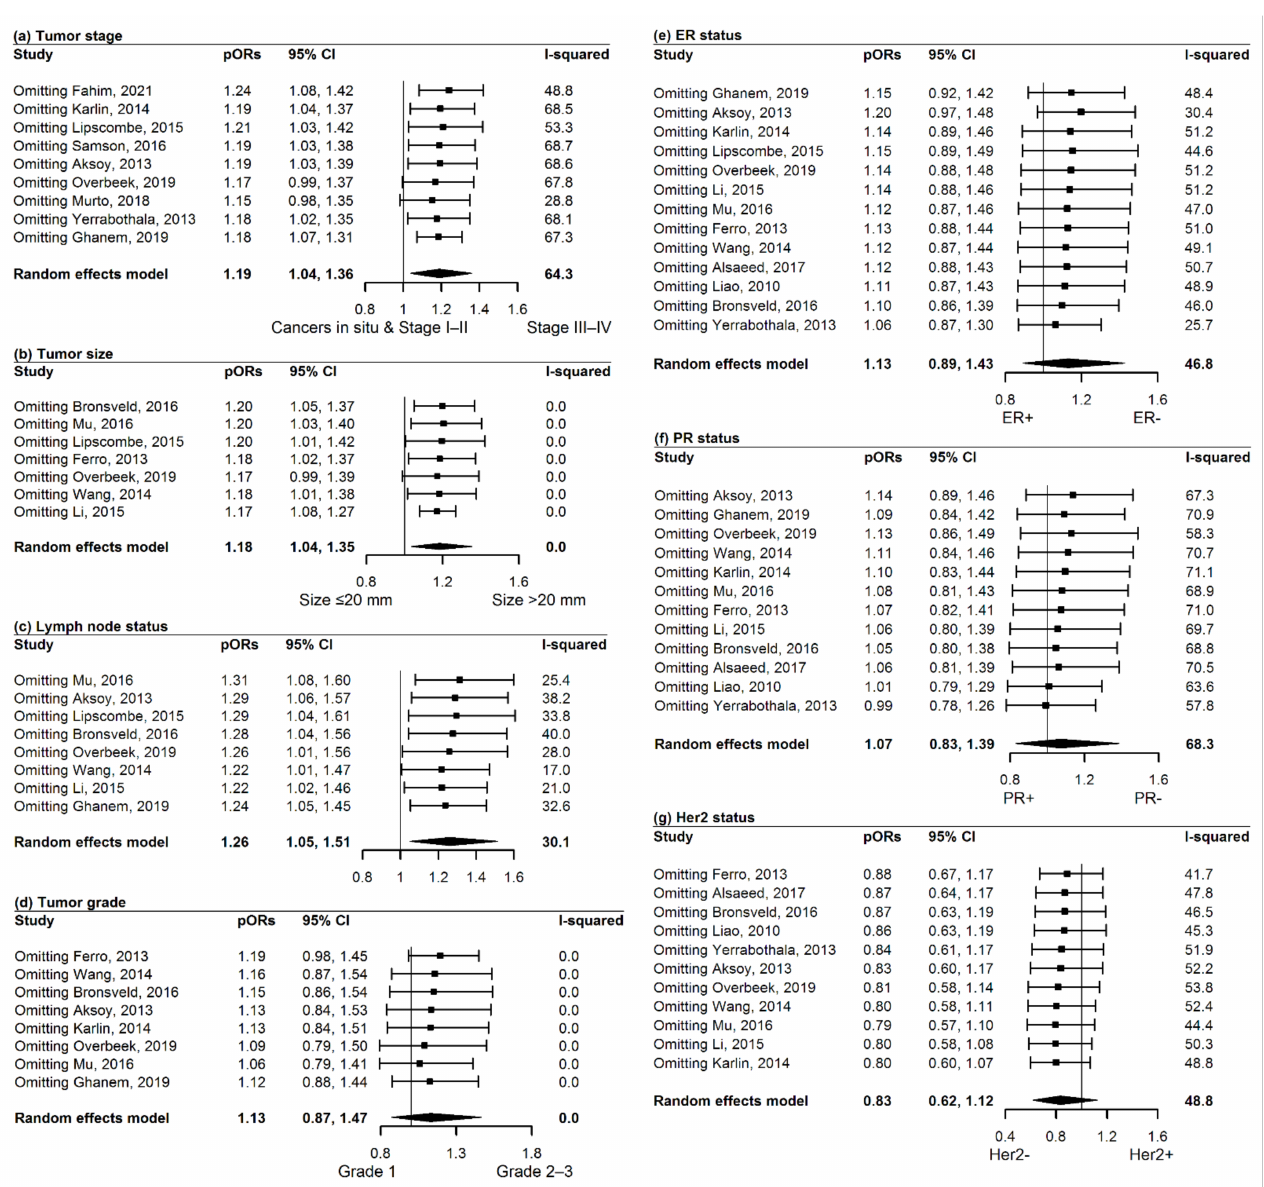
Figure 3. Influence analyses for examining impact of each article on the pooled estimates. Influence analyses were conducted for ( a ) tumor stage; ( b ) tumor size, ( c ) lymph node status, ( d ) tumor grade, ( e ) ER status, ( f ) PR status, and ( g ) Her2 status. pORs, pooled odds ratio; CI, confidence interval; ER, estrogen receptor; PR, progesterone receptor; Her2, human epidermal growth factor